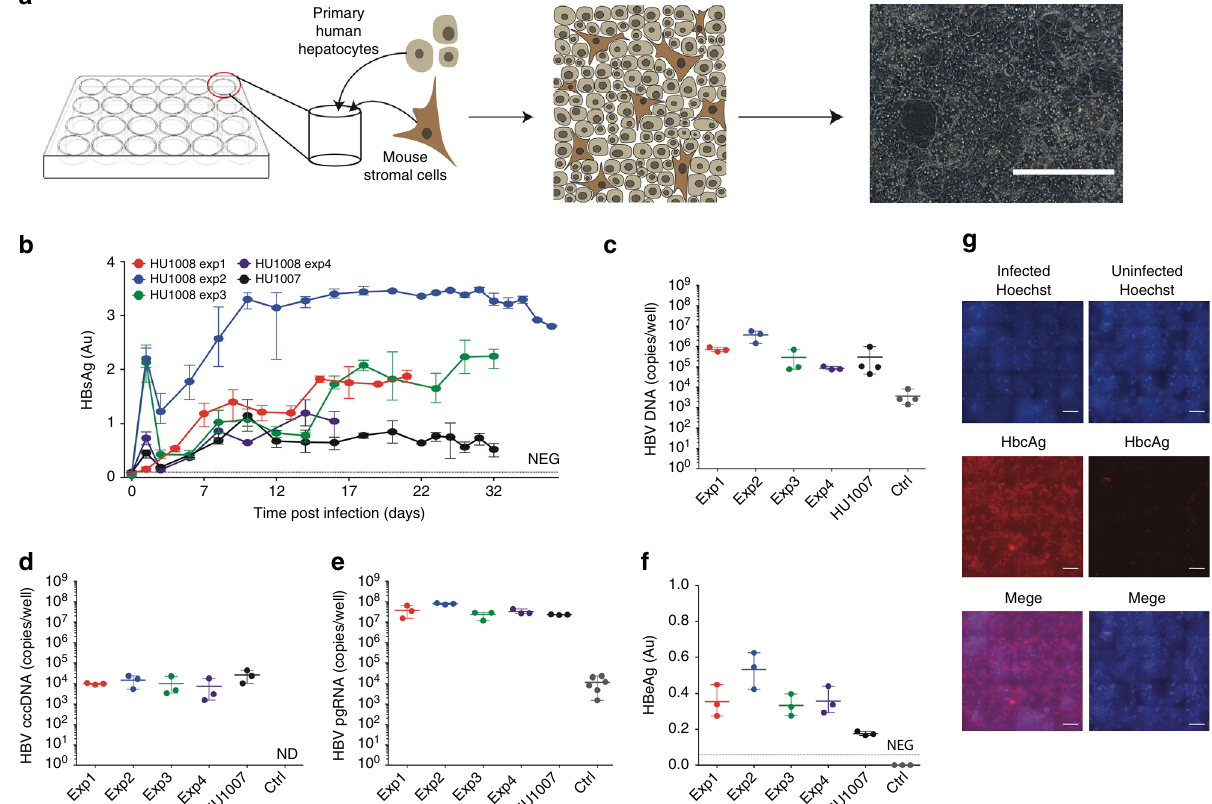
Fig. 1 Persistent HBV infection of self-assembling primary hepatocyte co-cultures. a PHH platform. HBVcc infection of mixed PHH donors performed in fi ve separate experiments with two separate lots of hepatocytes. HBsAg concentrations determined in the supernatants b and total HBV DNA c , HBV cccDNA d , HBV pgRNA e quanti fi ed in SACC-PHH lysates at the fi nal HBsAg timepoint. f HBeAg was quanti fi ed in the supernatants (day 16 post infection) by HBeAg ELISA. g HBcAg detection in HBV-infected ( left panels ) and non-infected ( right panels ) mixed donor SACC-PHHs by immuno fl uorescence microscopy; HBcAg ( red ), nuclear Hoechst dye ( blue ), all scale bars are 200 μ m. For all HBVcc infections of mixed PHH donors three to fi ve biological replicates were performed. All data are presented as means ±